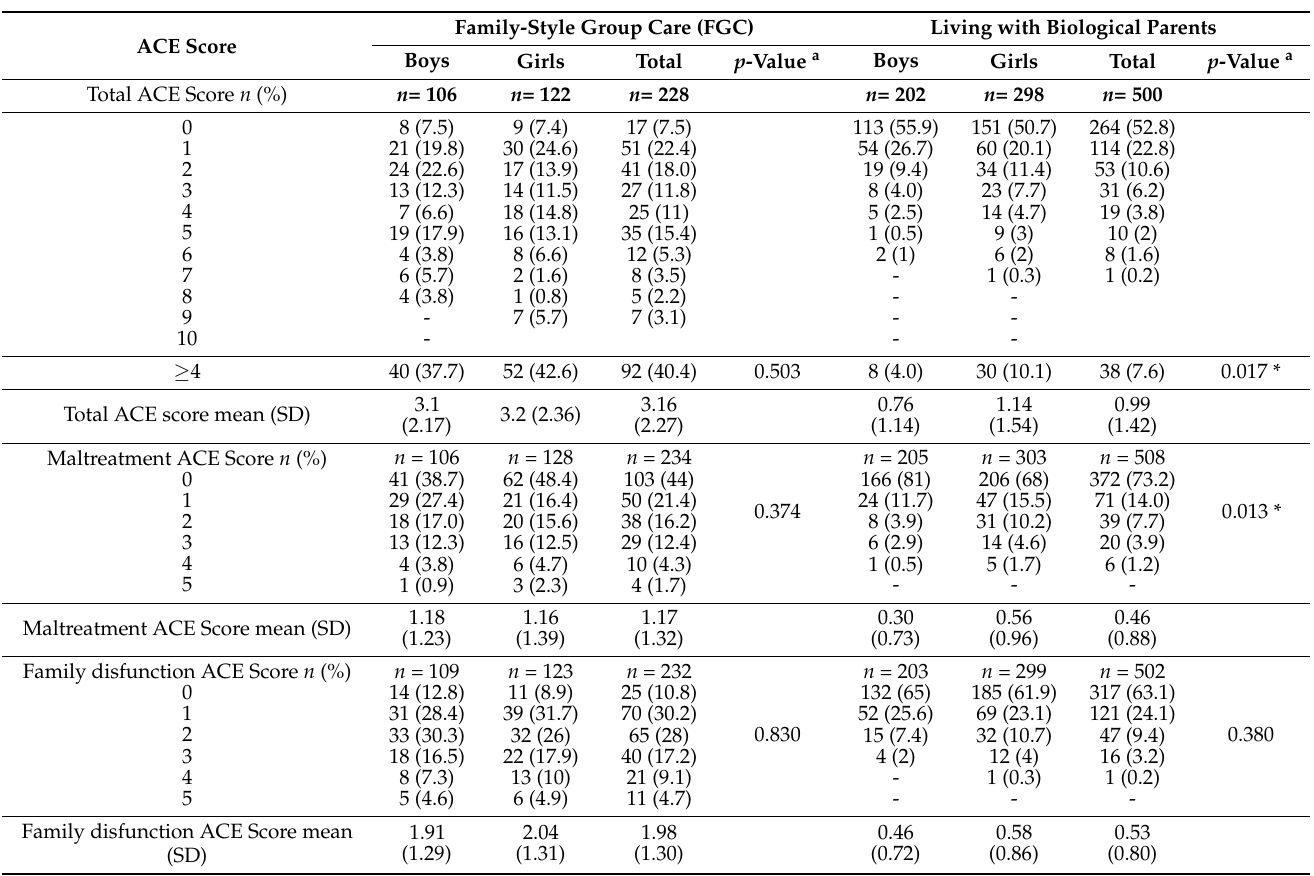
Table 2. Descriptive statistics of total ACE score, maltreatment ACE score, family dysfunction ACE score overall and by gender in the two